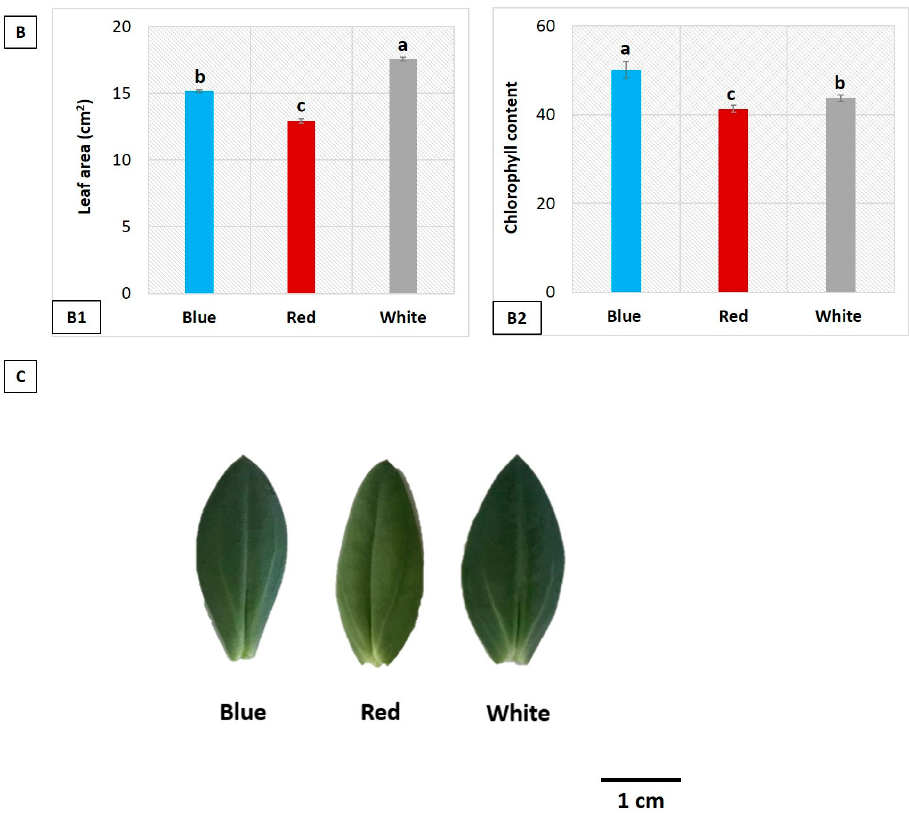
Figure 1. Effect of blue, red, and white LEDs on leaf traits of Eustoma . ( A1 ), leaf length (cm); ( A2 ), leaf width (cm); ( A3 ), leaf thickness (mm); ( A4 ), single leaf weight (g); ( B1 ), leaf area (cm 2 ); ( B2 ), chlorophyll content; and ( C ), leaf morphology. Data are mean values ( n = 10) and the vertical bars represent ± SE (Tukey’s HSD at P < 0.05)